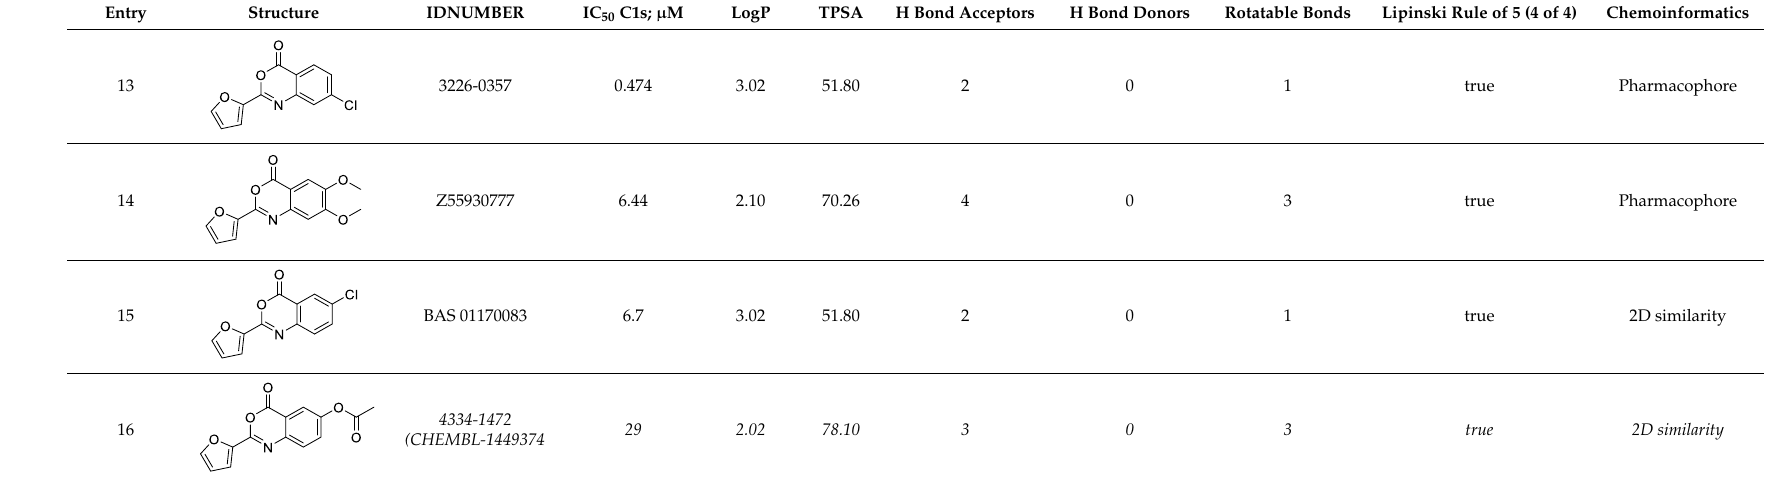
Table 3. Hit compounds derived from the 3,1-benzoxazin-4-one chemotype.